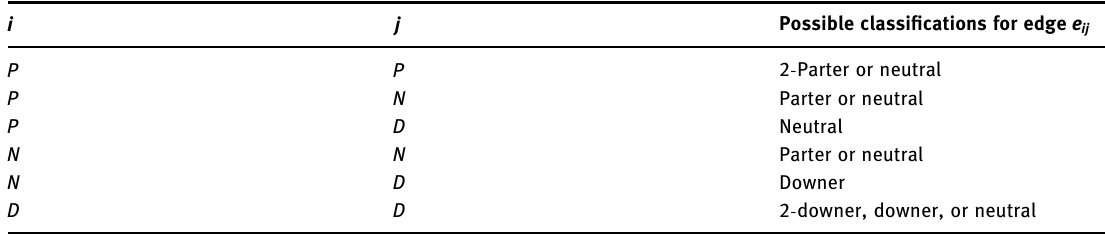
Table 1: Possible classi fi cation for edges in ( ) (cid:3) G j Possible classi fi cations for edge e